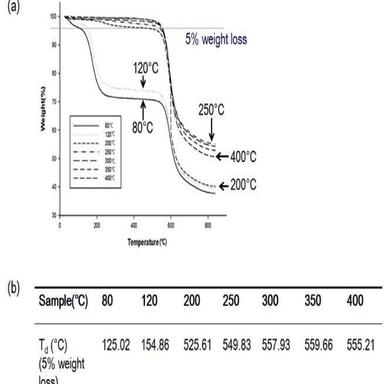
(a) TGA thermogram of PI films at different temperature (°C), and (b) Thermal degradation temperatures (Td) of PI films at different temperature (°C). Here, the final curing time was 10 min.